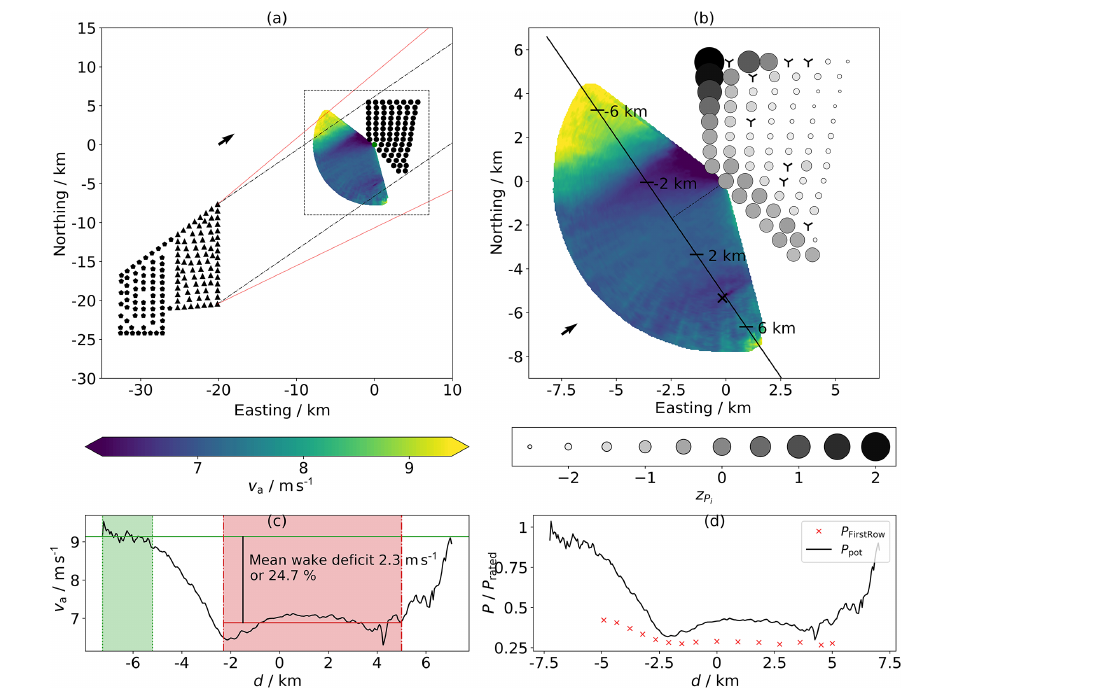
Figure 7. As in Fig. 6 but averaged over 60 consecutive lidar scans (scenario B) corresponding to a period of 157min (13:35–16:12UTC); power data averaged over 170min (13:30–16:20UTC). Red lines in (a) indicate minimal and maximal wind directions within the averaging